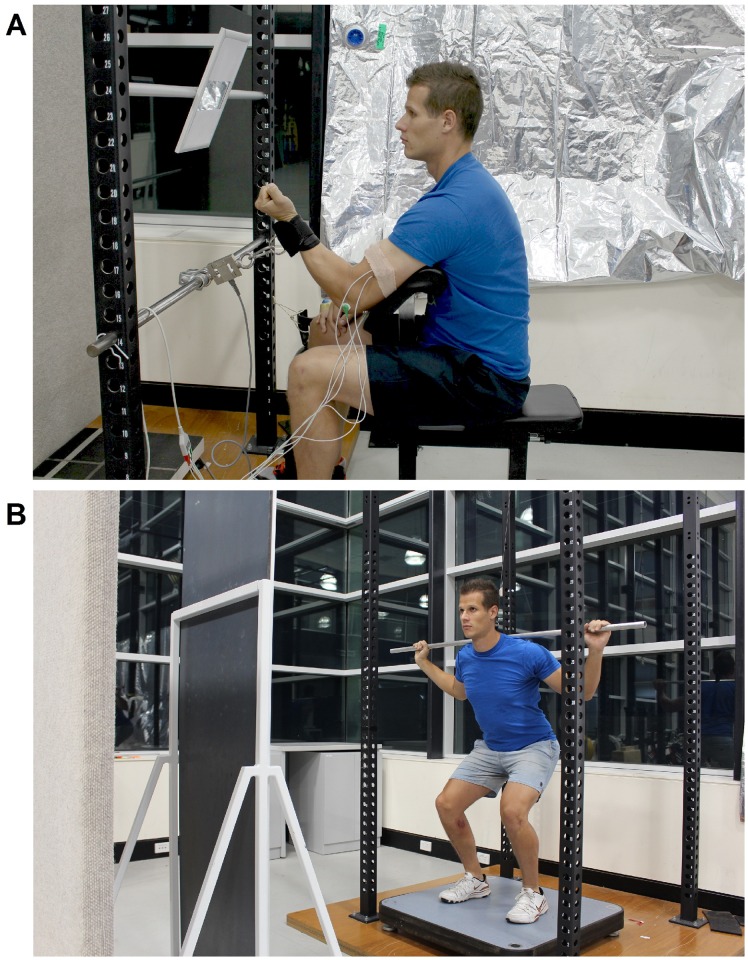
Experimental setup.(A) Single joint experiment. (B) Multi-joint experiment.